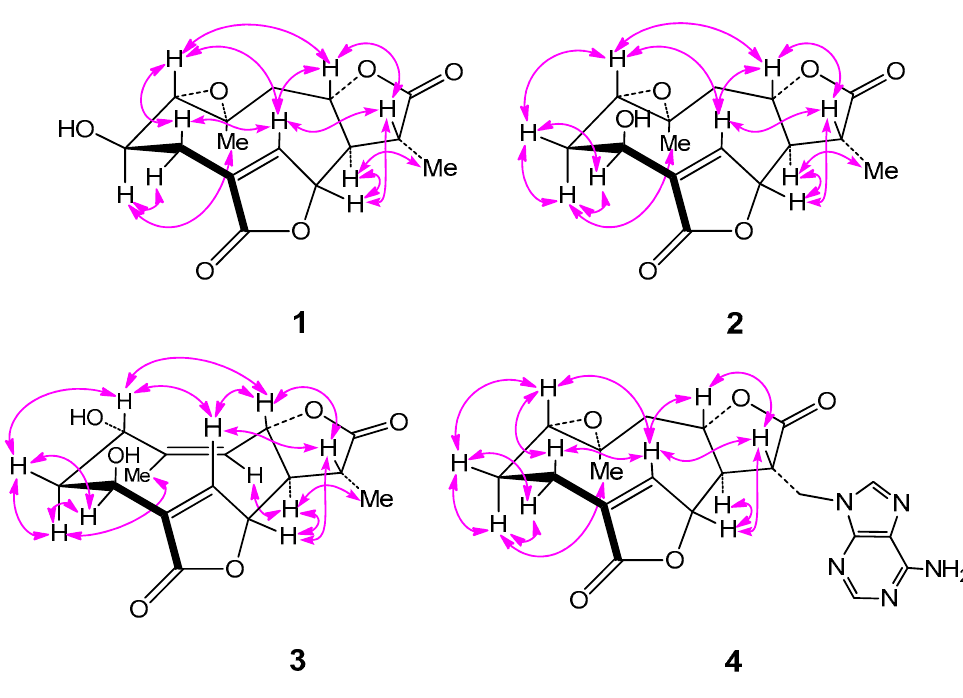
Figure 2. Key 1 H- 1 H COSY ( Figure 2. Key 1 H- 1 H COSY ( ) and selected HMBC ( ) correlations of 1 − 4 . ) and selected HMBC ( Figure 2. Key 1 H- 1 H COSY ( ) and selected HMBC ( ) correlations of 1 − 4 . ) correlations of 1 – 4 . Figure 2. Key 1 H- 1 H COSY ( ) and selected HMBC ( ) correlations of 1 − 4 . Figure 2. Key 1 H- 1 H COSY ( ) and selected HMBC ( ) correlations of 1 − 4 .